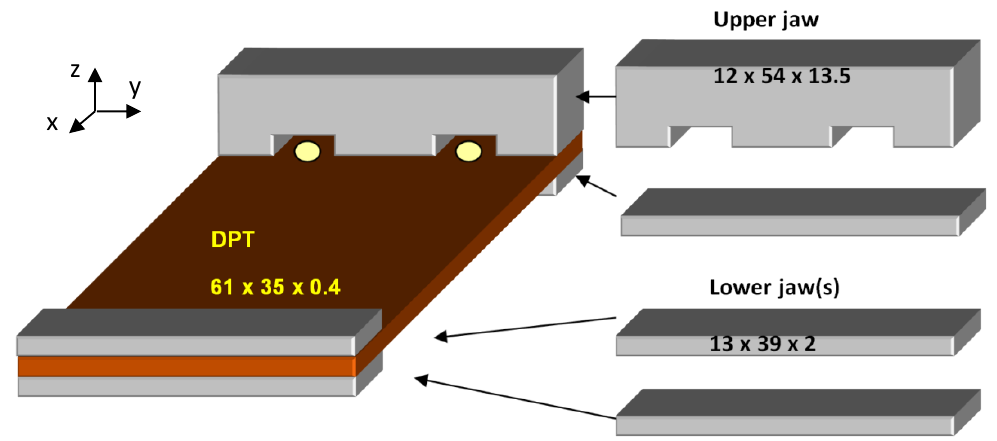
Figure 3. Mounting configuration of the DPT transducer in the experimental tests.